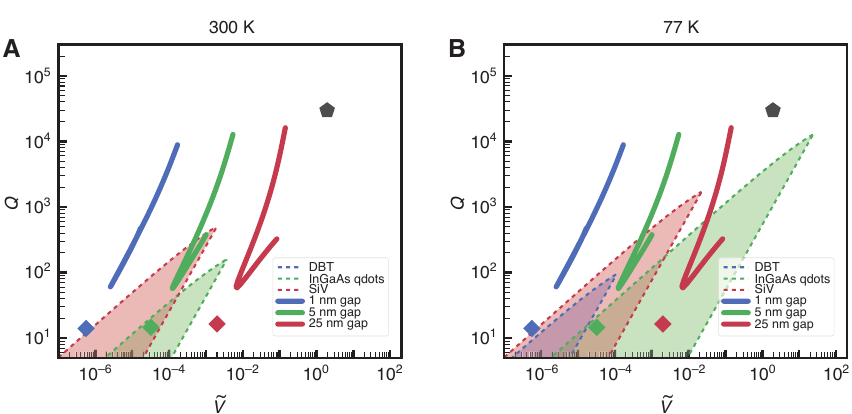
Figure 7: Conditions for indistinguishable photon sources, for different emitters at room temperature and 77 K. Conditions on Q and for indistinguishable photon emission at room temperature (A) and 77 K (B), for different emitters. We show Q and (cid:31) V of the same cavity, antennas and resulting hybrids as shown in Figures 4C and 5 (full curves and markers). Furthermore, for three emitters the shaded regions indicate the range of resonator Q and (cid:31) V for which a single-photon source with indistinguishability I ≥ 50% can be attained, i.e. Eqs. (11) and (12) are satisfied. Note that for DBT at 300 K, this region falls just outside the plot range. We show the same cavity (black marker), antennas (colored diamonds) and hybrids (full colored lines) as in Figures 4C, 5, and